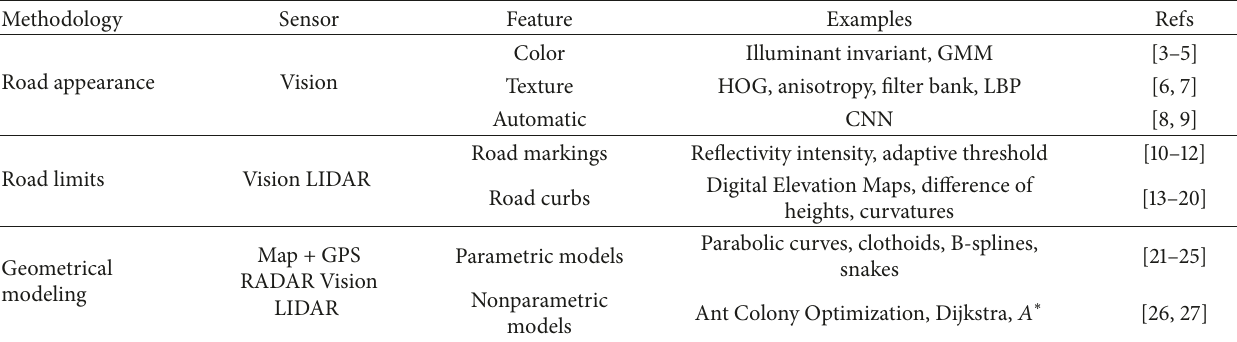
Table 1: Classification of different road detection